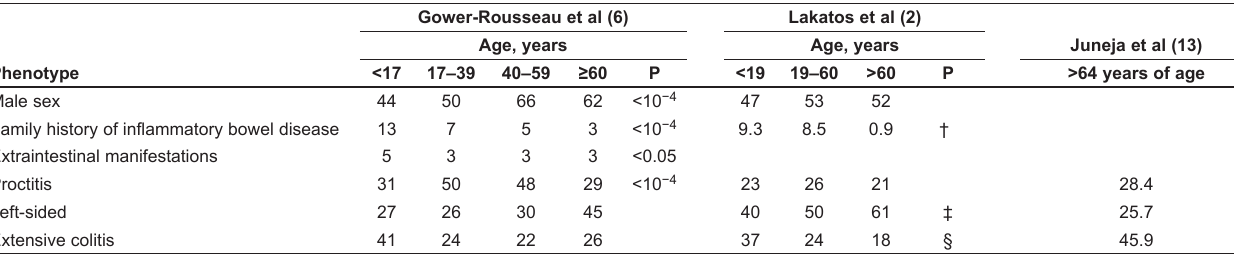
Table 3 Clinical phenotype of ulcerative colitis in elderly* patients